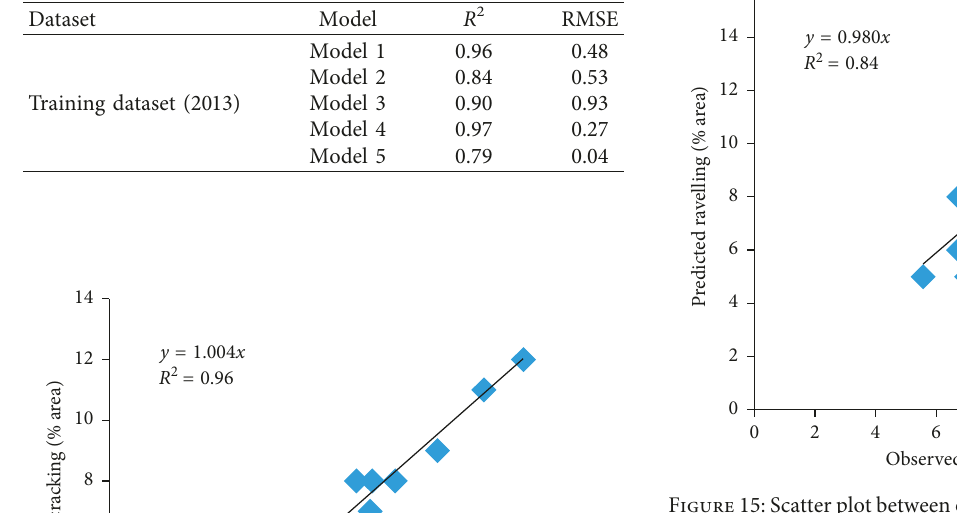
Figure 15: Scatter plot between observed versus predicted ravelling for training.